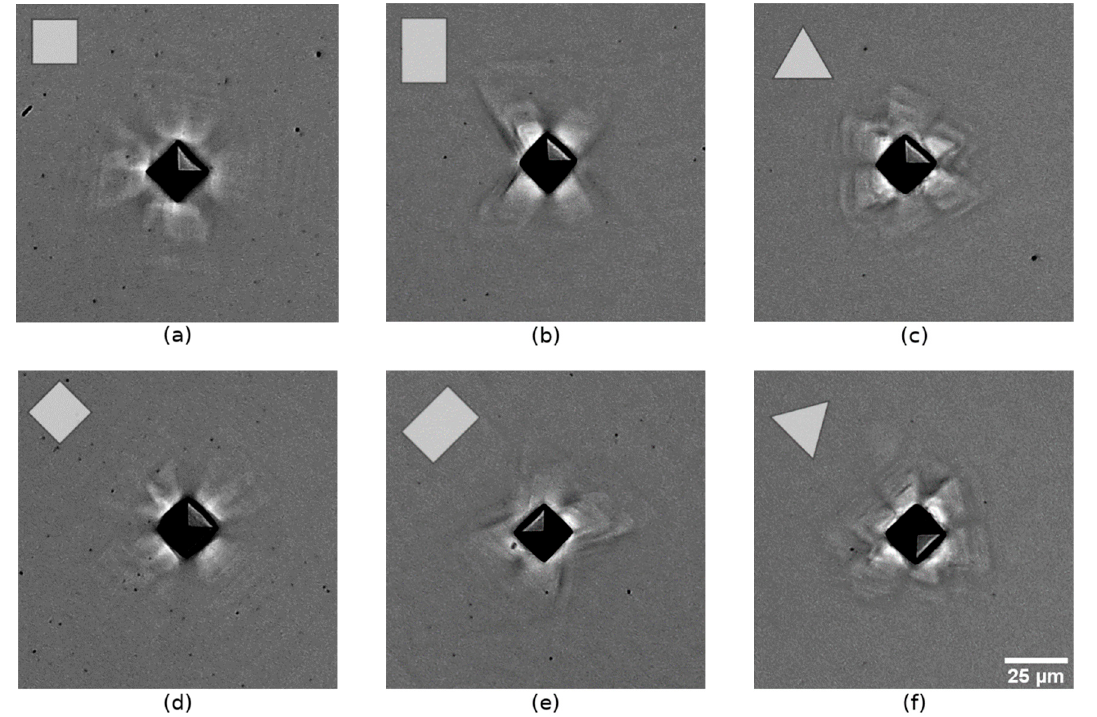
Figure 2. Optical images of pile-up patterns ( F max = 60 mN) on three crystallographic orientations of aluminum single crystals (aligned patterns, ( a ): (100), ( b ): (110), ( c ): (111)). Indents on the same surfaces azimuthally rotated by 45 ◦ (misaligned patterns, ( d ): (100), ( e ): (110), ( f ): (111)).